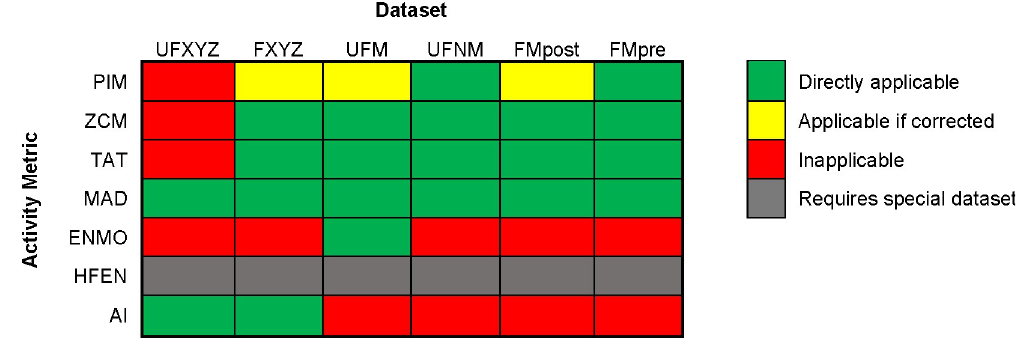
Fig 4. Summary of metrics’ applicability for the different datasets. Details are presented in S2 Appendix.